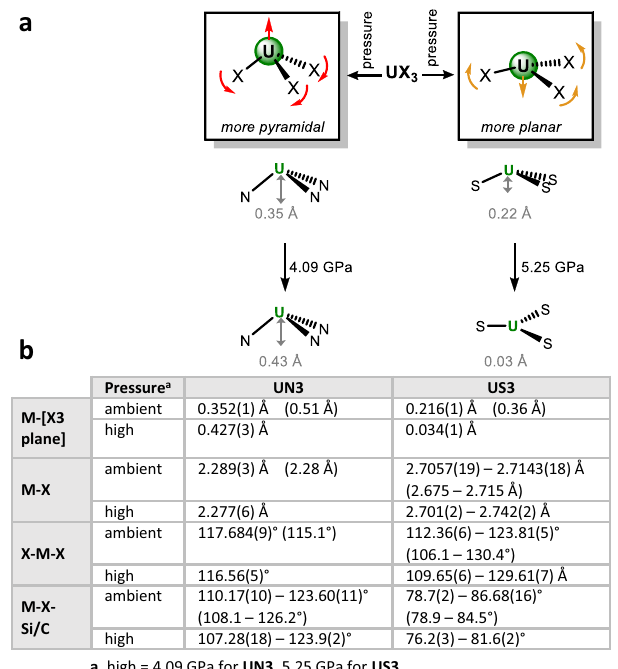
Fig. 2 The change in pyramidalization observed for UN3 and US3 with pressure. a Increased pyramidalization of UN3 with pressure, and planarization of US3 with pressure. b Key distances and angles and their change with pressure for the two compounds, with computed values in brackets. UN3 = U(N(SiMe 3 ) 2 ) 3 and US3 = U(SAr) 3 where SAr = arylthiolate S- t Bu 3 − 2,4,6-C 6 H 2 .